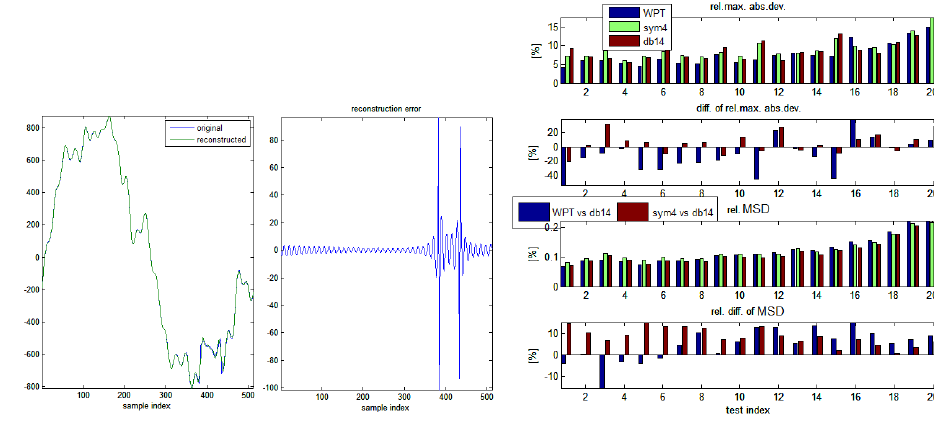
Figure 16. From top to bottom: relative maxim absolute deviations; relative percentage di ff erences (with db14 as reference) for relative maxim absolute deviations ; mean square rela- tive deviations; relative percentage di ff erences (with db14 as reference) for mean square rela- tive deviations, 2-nd